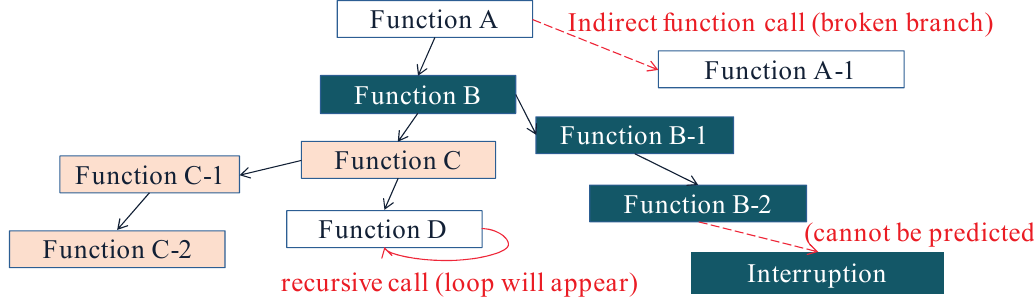
Figure 2. The thread control-flow graph modeled by the stack-size analysis